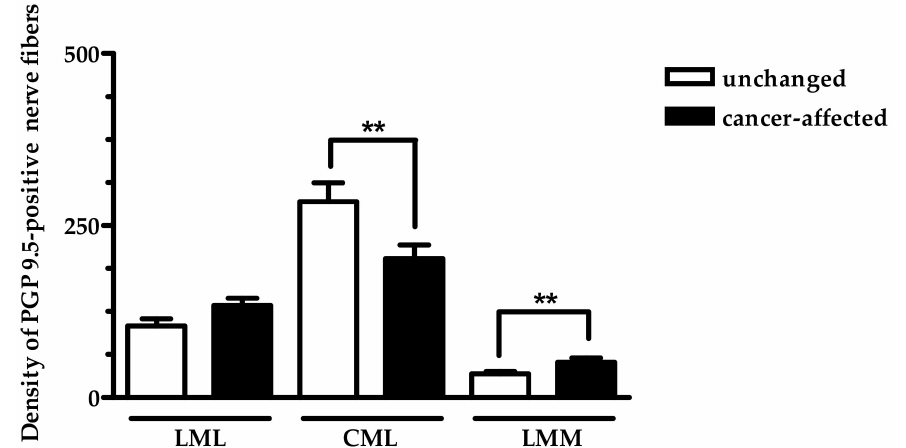
Figure 3. The mean number of PGP 9.5-positive nerve fibers counted in particular muscle layers of the surgical margin (open bars) and cancer-affected wall of the human stomach. Data were pooled and presented as the mean (range) of 10 patient. Abbreviations: LML—longitudinal muscle layer; CML—circular muscle layer; LMM—lamina muscularis mucosae. Data are presented as average number of nerve fibers ( ± SD) per area studied (900 µ m × 700 µ m). ** p <